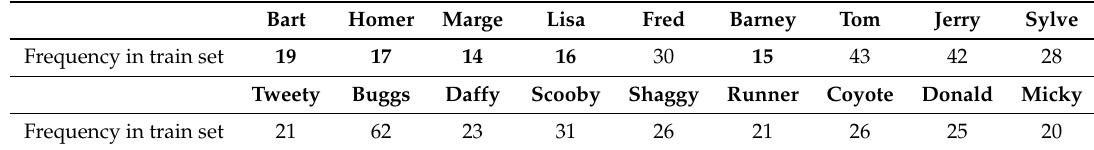
Table 4. Number of examples in training set for 18 classes.